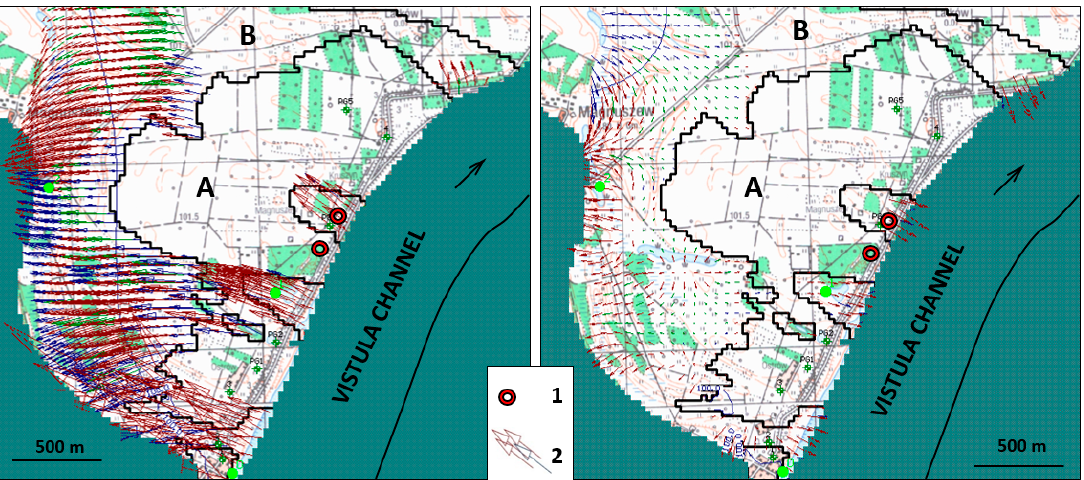
Figure 5. Groundwater flow under conditions of high (left) and low (right) water level; south part of studied area; plots from the MODFLOW model; A—outcrops of loamy flood deposits; B—transformed surface as well as filled crevasses; 1—piezometer; acc. [19] 2—flow vector.